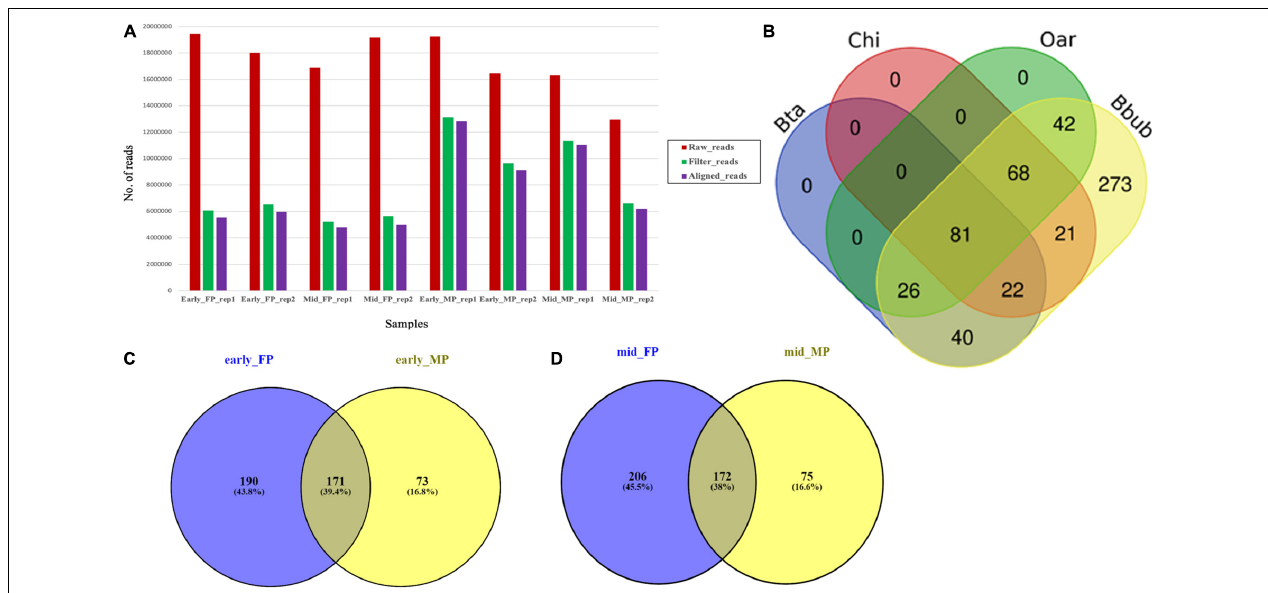
FIGURE 2 | (A) Abundance of raw, trimmed, and aligned reads in early and mid caruncular (MP) and cotyledonary (FP) placentome samples. (B) Distribution of conserved miRNAs in different ruminant species (Bta, Bos taurus /cattle; Chi, Capra hircus /goat; Oar, Ovis aries /sheep, Bbub/buffalo) using RumimiR database. (C) Venn diagram for miRNAs identified in early-stage fetal placentome early_FP (cotyledon) and maternal placentome early_MP (caruncle). (D) Venn diagram for miRNAs identified in mid-stage fetal placentome mid_FP (cotyledon) and maternal placentome mid_MP (caruncle).